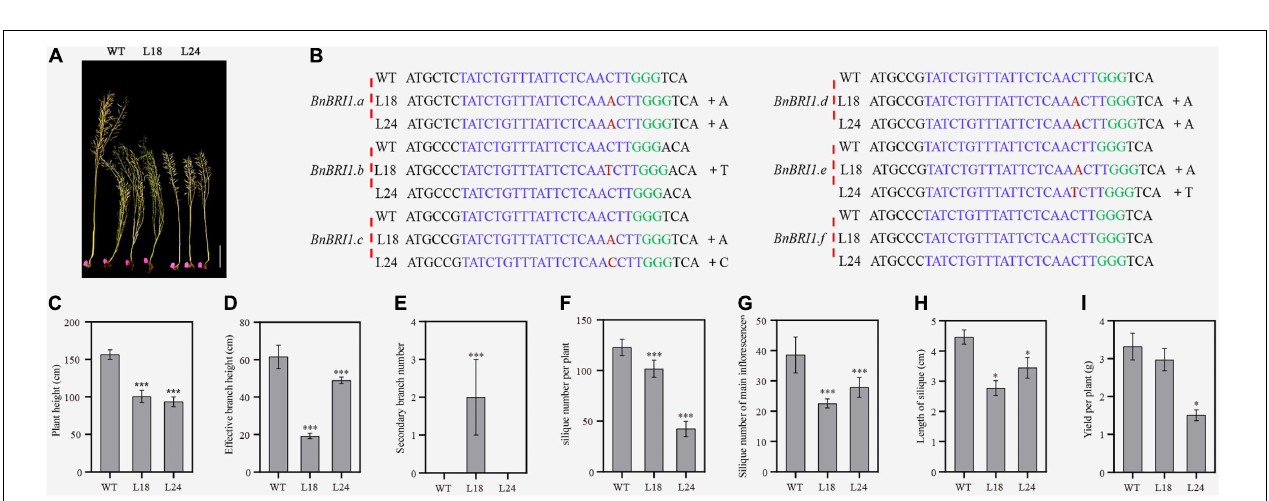
FIGURE 6 | Sequencing results of BnBri1 mutants and their agronomic traits. (A) Semi-dwarf material obtained by editing BnBRI1 from left to right were WT (K407), L18 and L24 strains, scale bars, 20 cm. (B) Sequencing results of L18 and L24 strains. The sgRNA targeting sequences are highlighted in blue and the PAM sequences are green. (C–I) Statistical analysis of plant height, effective branch height, secondary branch number, silique number per plant, silique number of main inflorescence, yield per plant and length of silique in WT (K407), L18 and L24 homozygous plants from the greenhouse. Error bars standard deviation ( n = 10). One-way analysis of variance was used for statistical analysis (“ ∗ ,” corresponding to P < 0.05, and “ ∗∗∗ ,” corresponding to P <